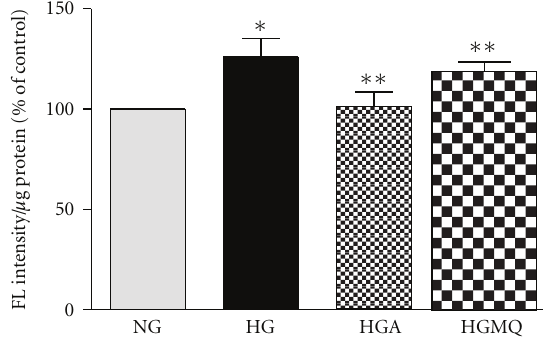
Figure 3: Apocynin reverses continuous high glucose-induced ROS production in BRP . Subconfluent cells in 24-well plate were exposed to normal glucose (NG, 5.6 mM) and continuous high glucose (HG, 25mM) in the absence and presence of 500 μ M apocynin (HGA) or 1 μ M MitoQ (HGMQ) for 3 days. Approximately, 2h before the end of incubation, DHE (10 μ M) was added. After the treatment, the cells were washed twice with PBS, lysed and fluorescence (FL) intensity was measured. Data are presented as mean ± SEM of 6 separate experiments. ∗ P < . 05 versus NG, ∗∗ P < . 05 versus HG.